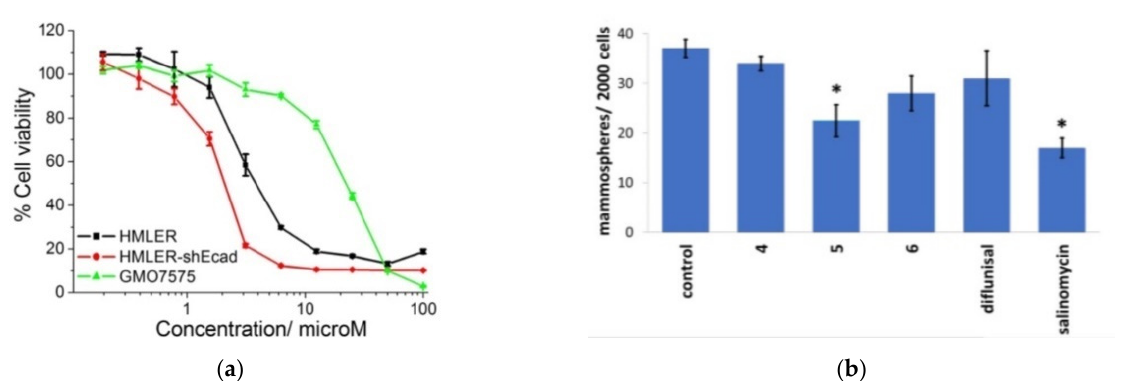
Figure 12. Dose–response relationship of cobalt (III) complex (composition number 5) against HMLER (bulk breast cancer cells), HMLER-shEcad (breast cancer stem cells), and GMO7575 (skin fibroblast) cell lines after 72 h of incubation ( a ). Quantification of mammosphere morphosis with HMLER-shEcad cells without and with the addition of complexes obtained, pure diflunisal, and pure salinomycin at their respective IC 20 values for 5 days ( b ). Error bars are equal to standard deviation (SD); for Student’s t-test * p < 0.05. Reproduced from [51], with permission from the Royal Society of Chemistry, 2021.